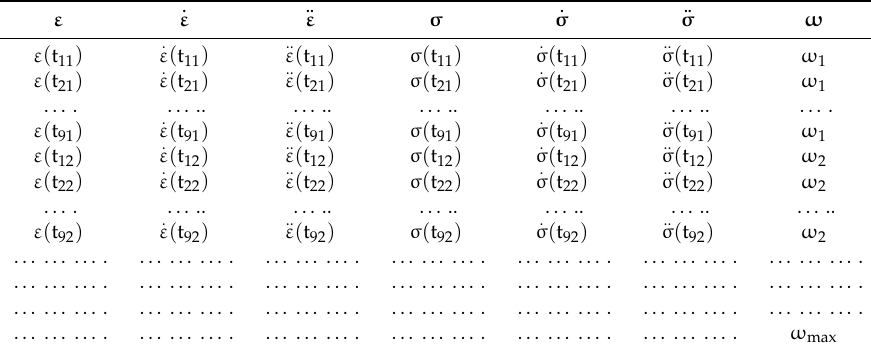
Table 1. Structure of the data—calculable from the rheological